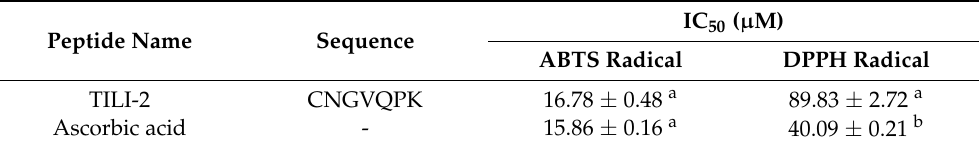
Table 3. The half-maximal inhibitory concentration (IC 50 ) of TILI-2 against ABTS and DPPH radicals.